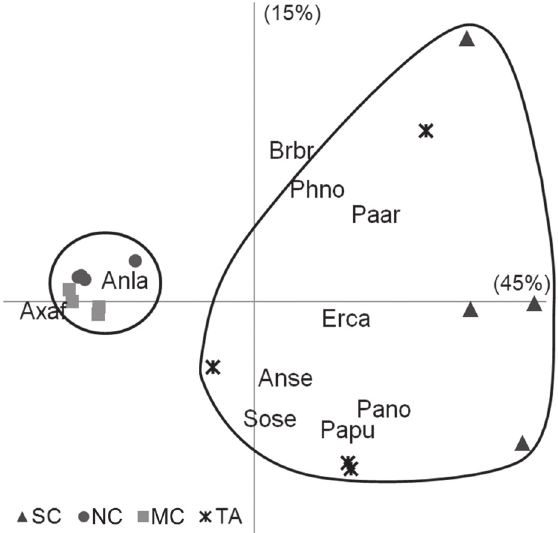
Figure 4 - Principal coordinate ordination diagram showing the first two axes. Only species with higher correlations to the axes are shown (corr.>0.4). Symbols represent the subregions and continuous lines delimit groups of sampling units that were similar in species composition (ρ<0.05). Axaf: